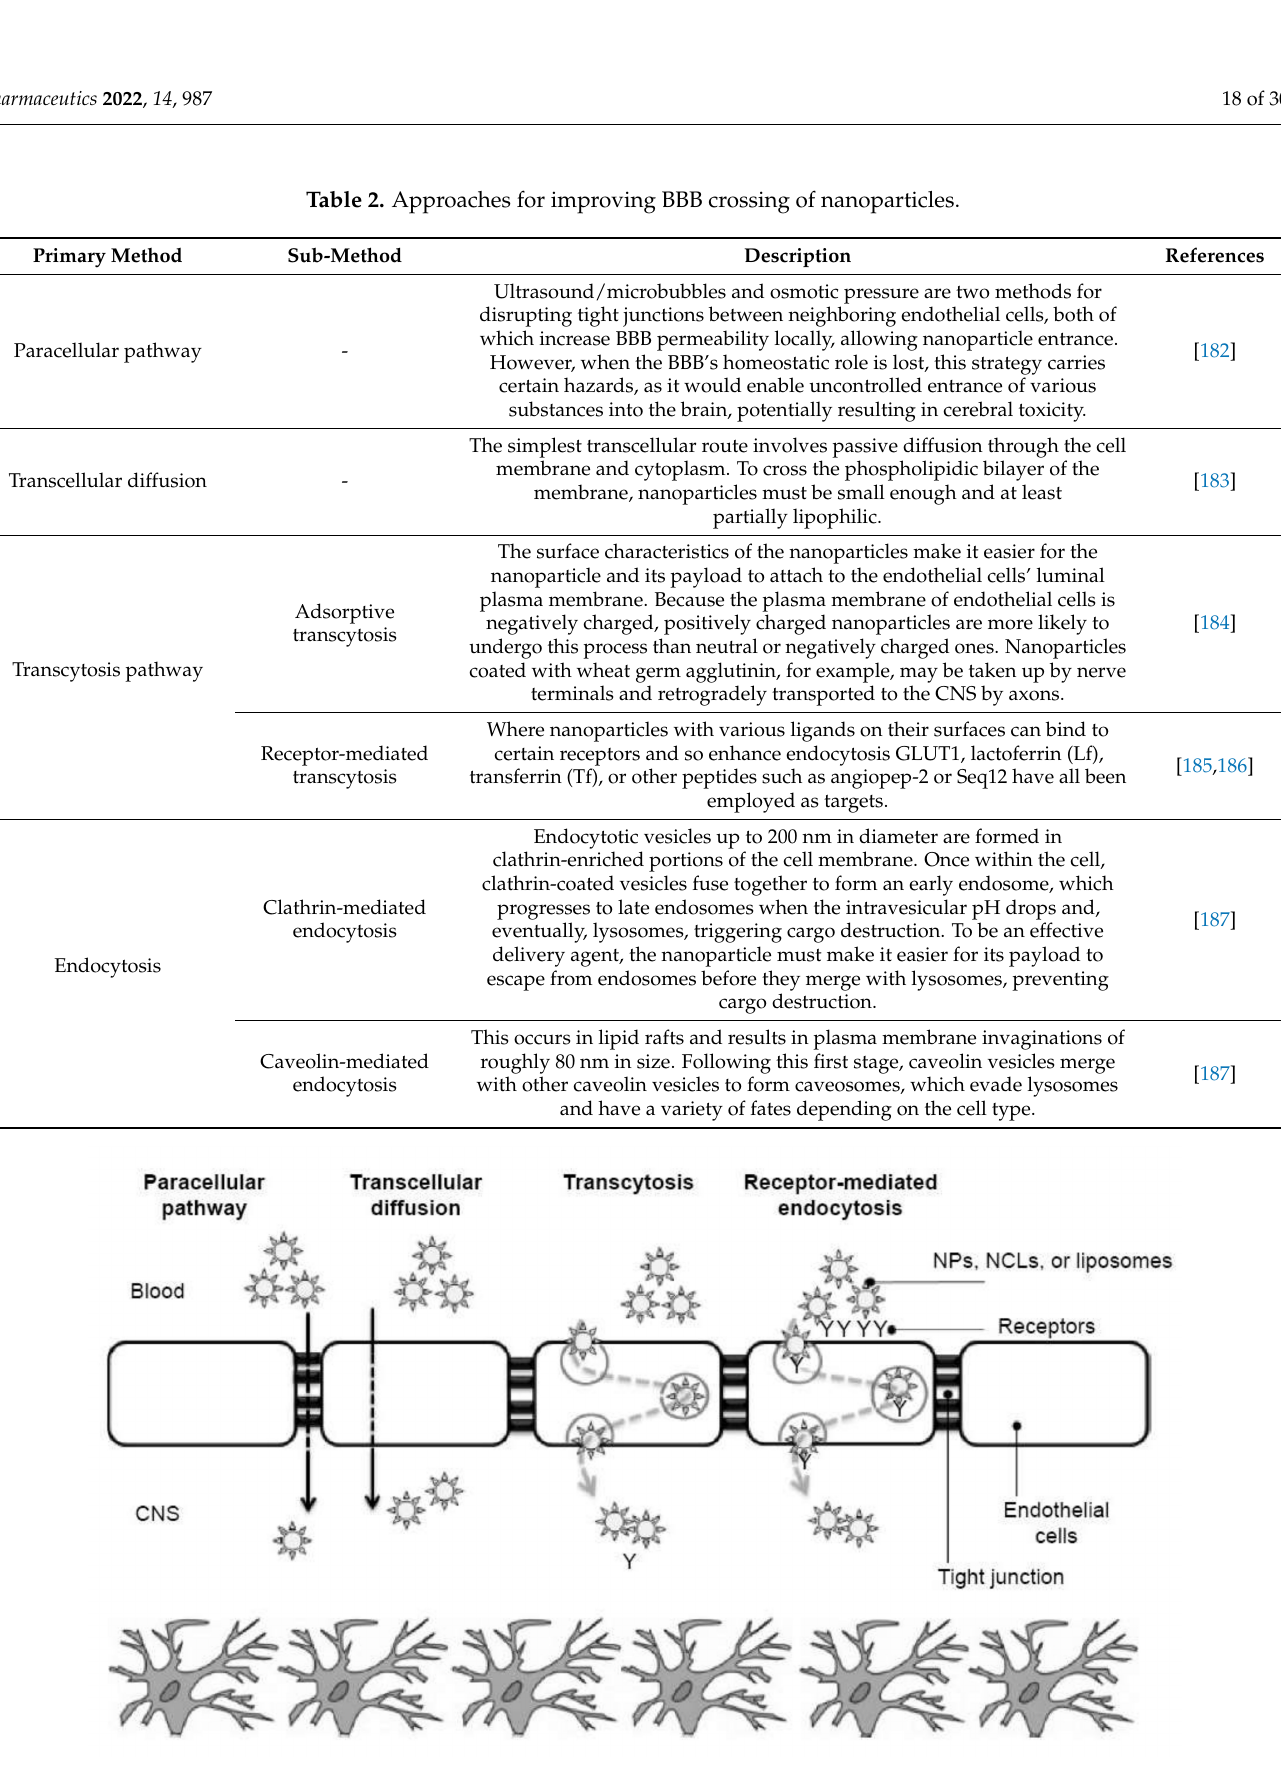
Figure 6. Main BBB crossing pathways for nanosystems. Abbreviations: CNS–central nervous system; NCL–nanostructured lipid carriers; NPs–nanoparticles. Reprinted from Ref. [188], Dove Press Ltd.,